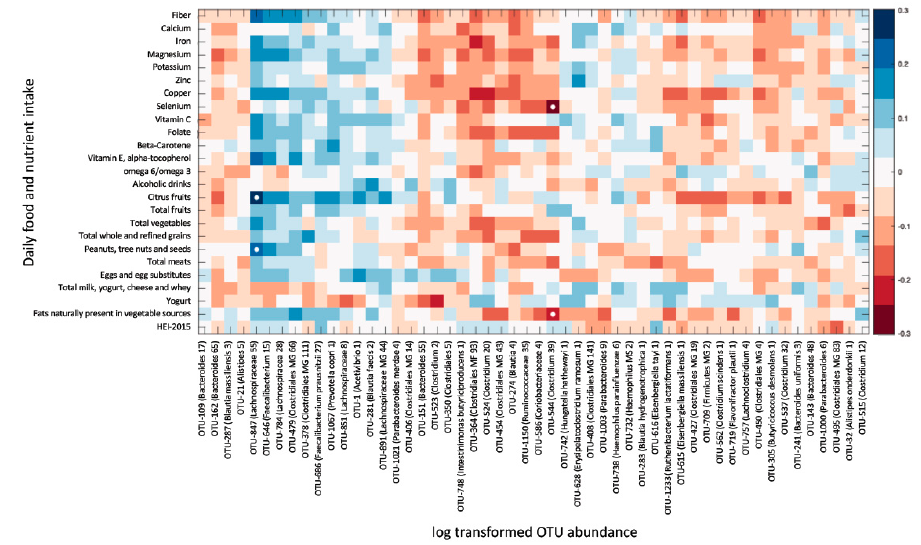
Figure 3. Daily nutrient intake is mostly not associated with the relative abundance of OTUs differentially abundant (DA) in fibromyalgia. Heat map of a univariate Kendall correlation matrix between DA taxa abundance (log2; x -axis) and selected daily macro- and micronutrient, and food group intake ( y -axis). Heatmap is sorted based on a hierarchical clustering of DA OTUs. Blue shades indicate positive correlations while red shades indicate negative correlations ( − 0.3 < tau < 0.3). Statistically significant correlations (BH FDR p < 0.05) are marked with a white circle. Food intake units are provided in Table 3. HEI 2015–Healthy Eating Index 2015.